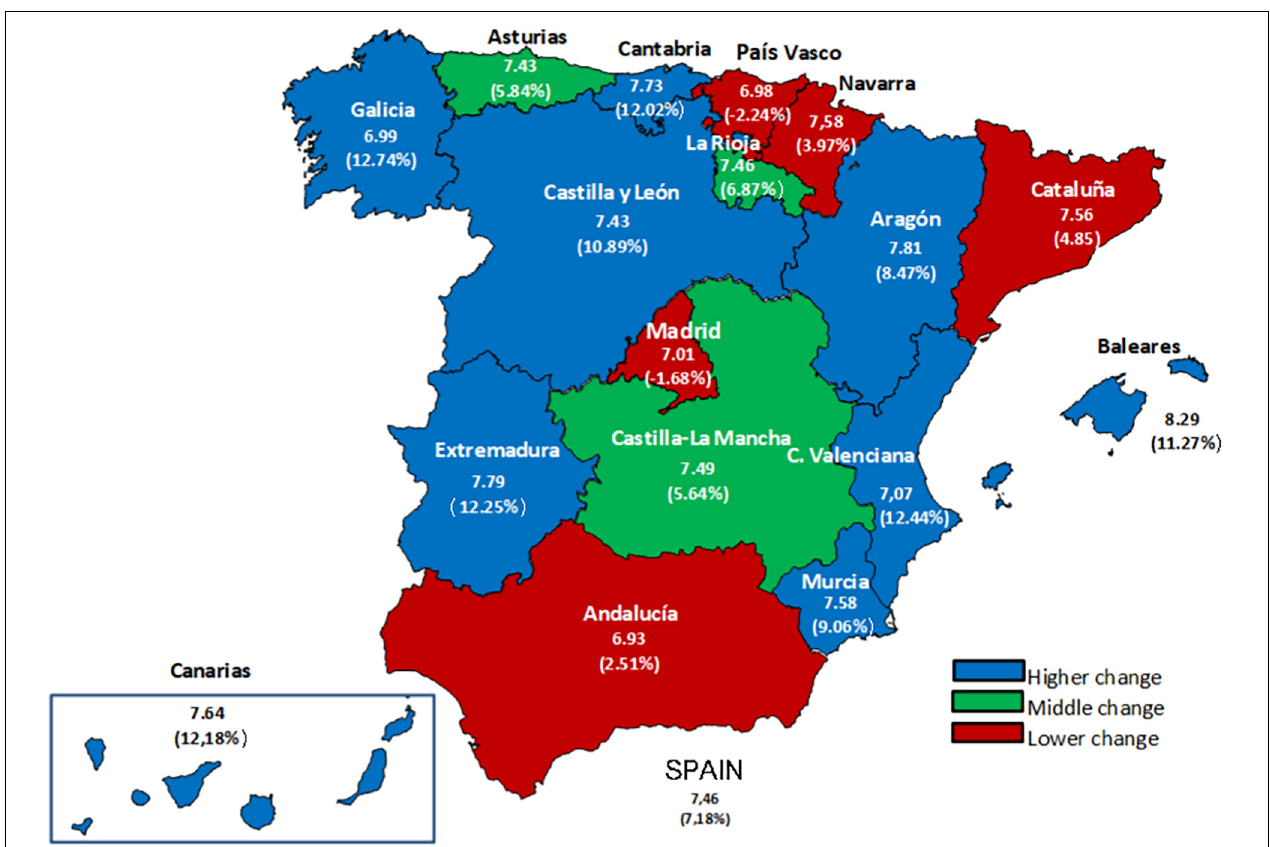
FIGURE 2 | Geographic distribution of SWB by regions in 2018 (change in